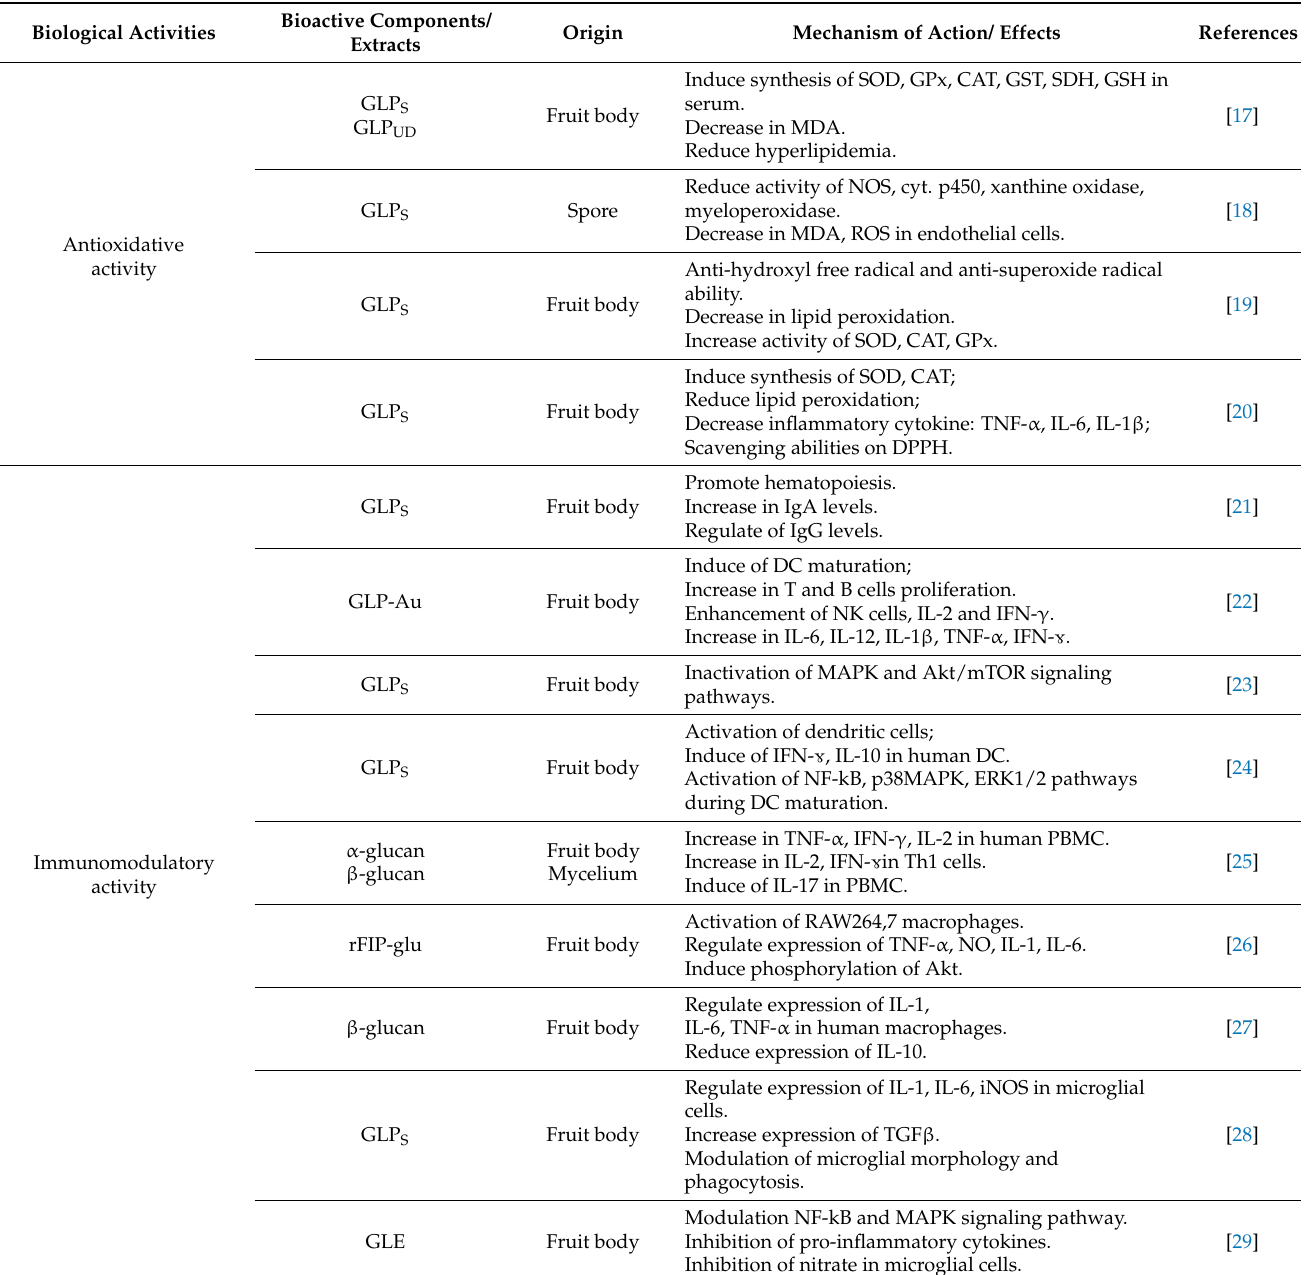
Table 1. Biological activities, mechanism of action/effects of polysaccharides from Ganoderma lucidum